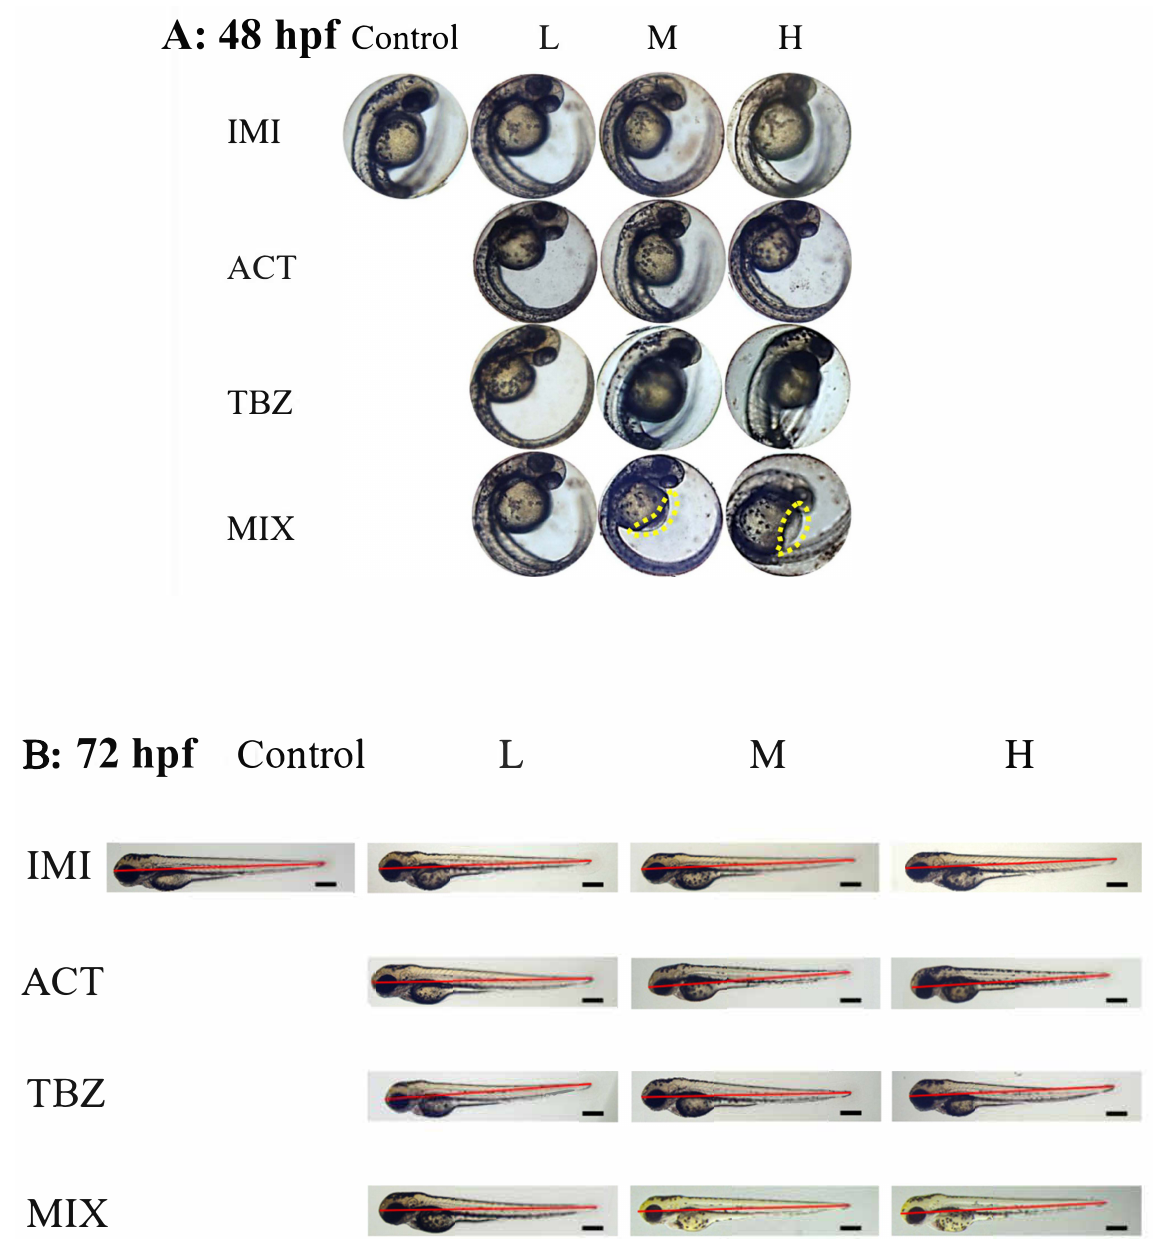
Figure 1. Effects on F1 offspring embryos after individual and combined exposure to adult zebrafish. ( A ) F1 offspring embryos developed to 48 hpf when the middle concentration of the combined expo- sure group started to have yolk sac edema deformation (within the yellow dashed line). ( B ) At 72 hpf, the yolk sac edema deformation recovered, and the red lines indicate body length. Scale bar = 200 µ m. Here L: low concentration, M: medium concentration and H: high